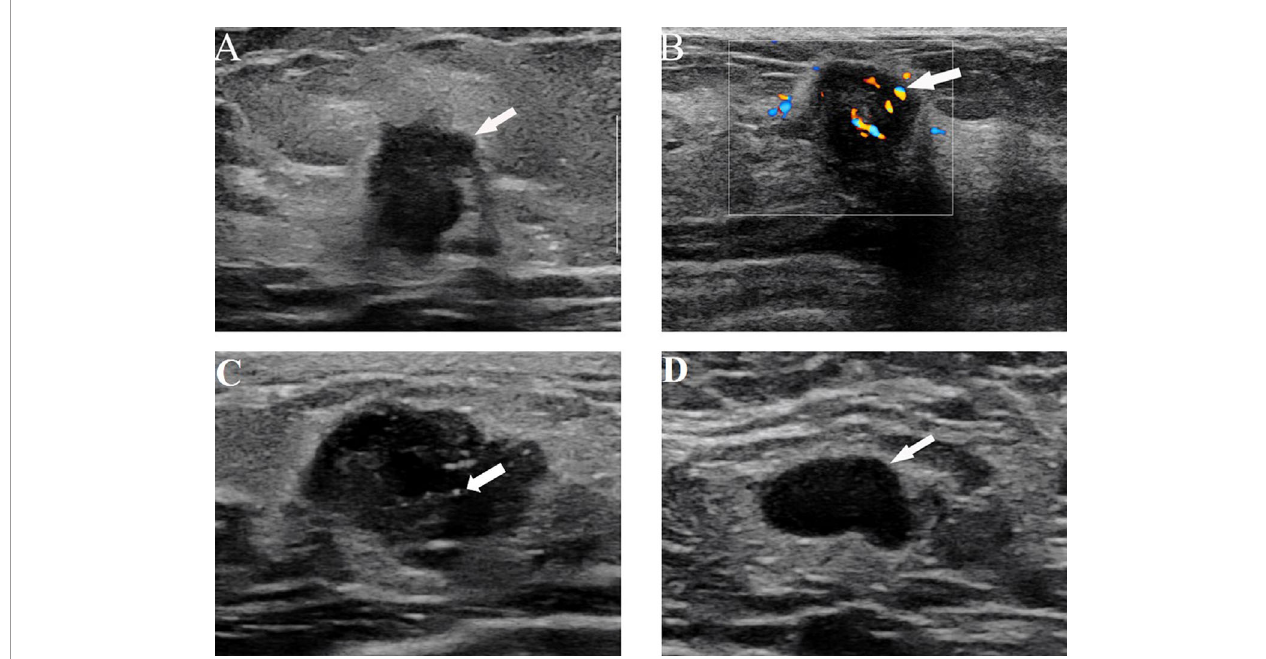
FIGURE 3 | (A) US image from a 64-year-old woman with ALN metastasis showing the irregular shape and nonparallel growth of the tumor. (B) US images from a 38-year-old woman with ALN metastasis showing rich blood fl ow signals with the application of color Doppler fl ow. (C) US images in a 40-year-old woman with ALN metastasis, which shows microcalci fi cation and an irregular shape. (D) US images from a 62-year-old woman with ALN metastasis showing the absence of a central